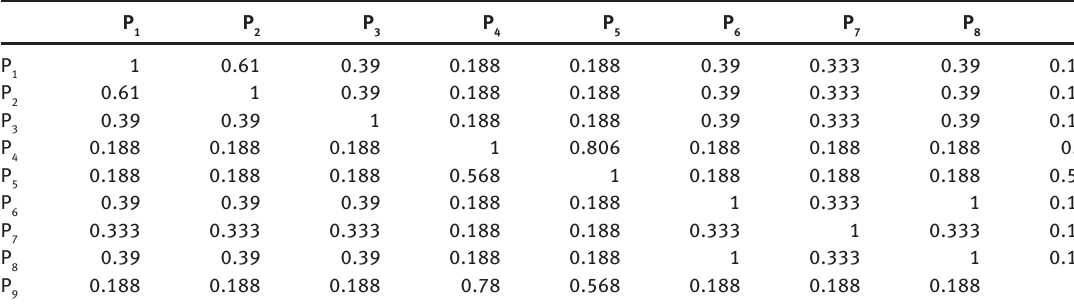
Table 5: Classification of Patients: Fuzzy Equivalence Relation Obtained Using the Max-Min Method (Nine Patients, Eight